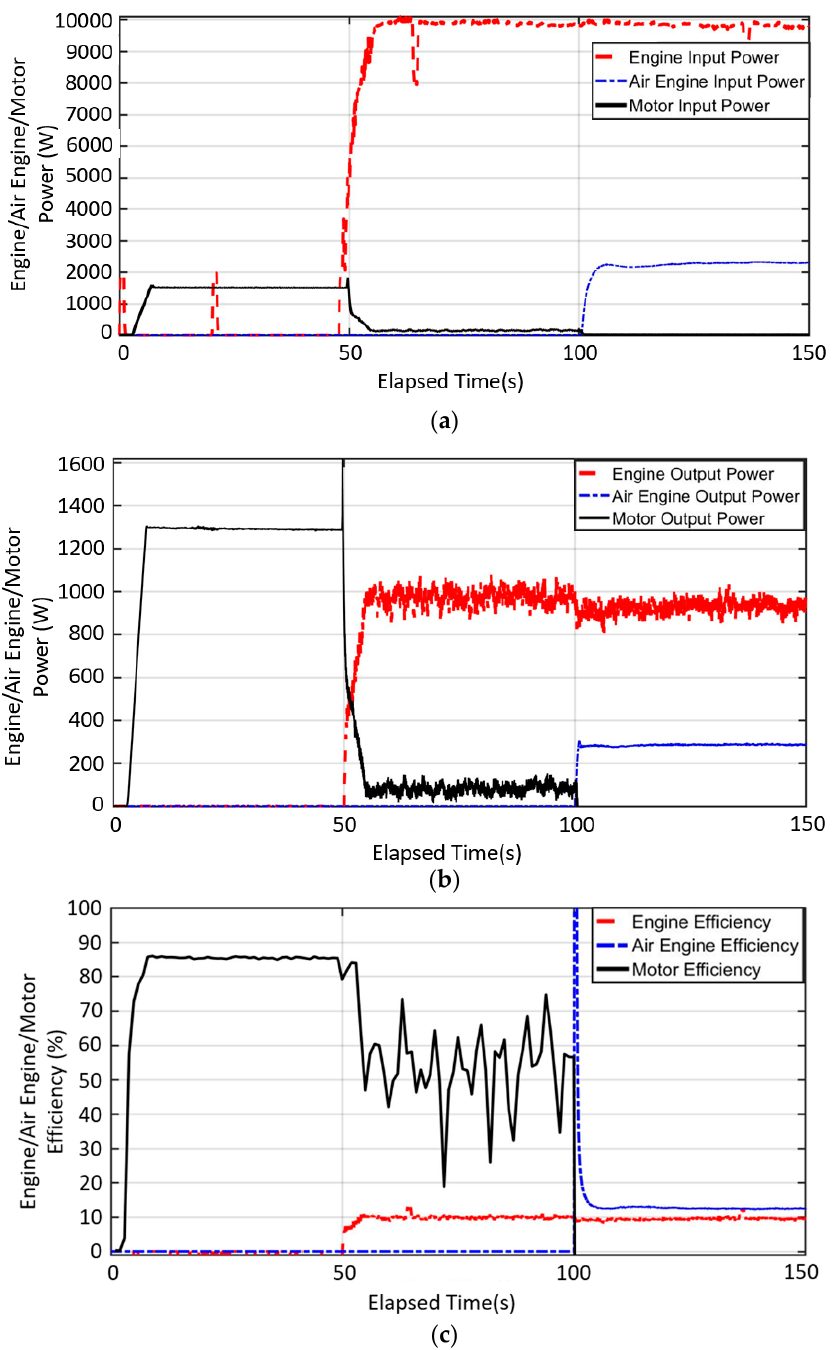
Figure 17. Engine/motor/air engine hybrid mode: ( a ) input power, ( b ) output power; and, ( c ) efficiency